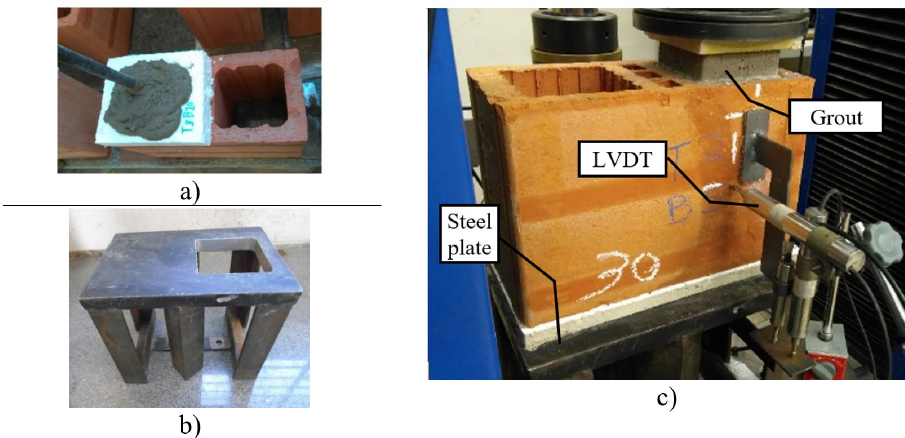
Figure 3. Scheme of push-out